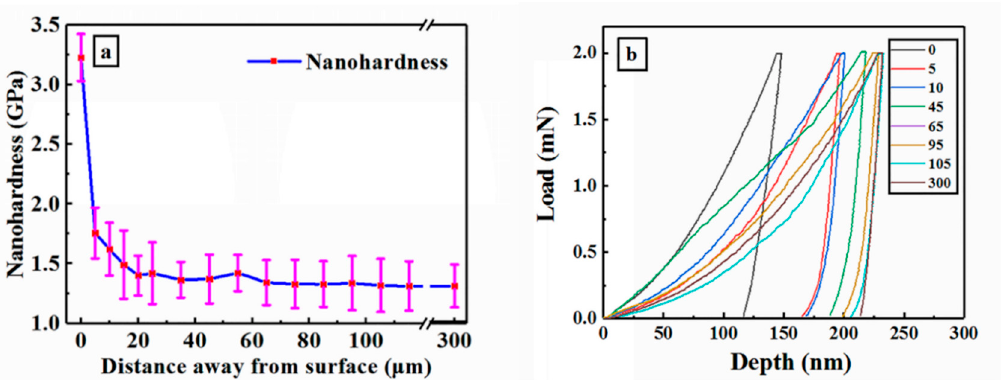
Figure 8. The cross-sectional nanoindentation tester results of Al–20Si–5Mg alloy after HCPEB treatment with 25 pulses: ( a ) evolution of nanohardness with distance away from surface; ( b ) evolution of load with depth away from top surface.